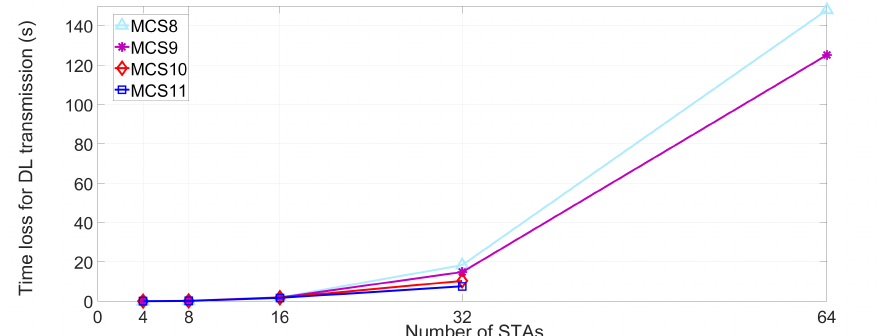
Figure 7. Expected time loss l t for DL transmission.